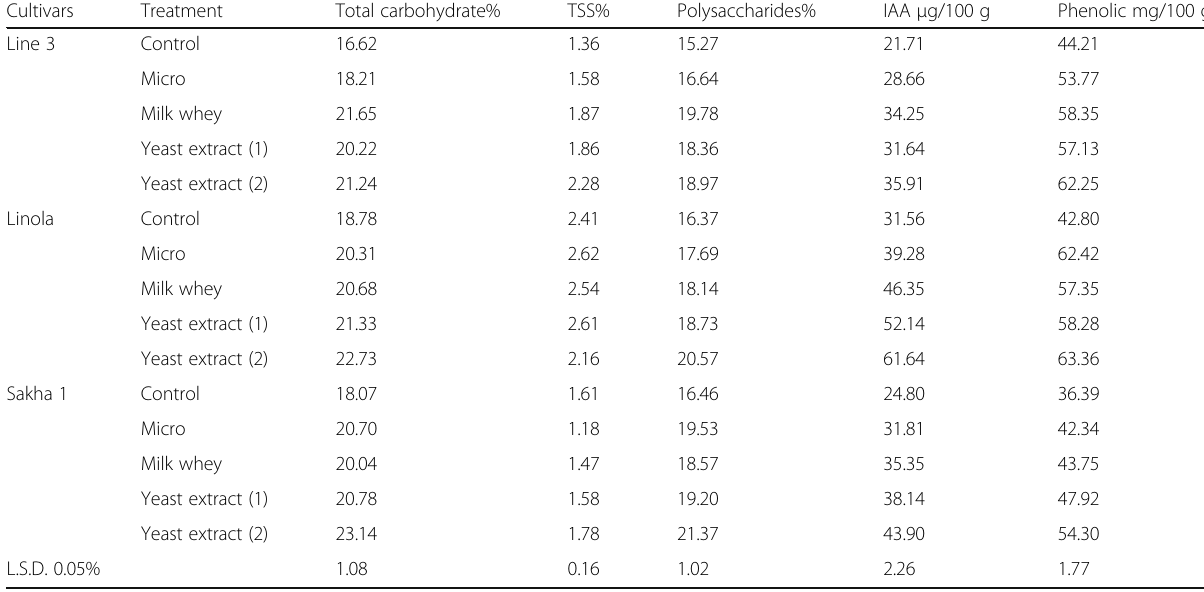
Table 8 Effect of interaction between flax cultivars and bio-fertilizer treatments on some chemical contents of leaf Cultivars